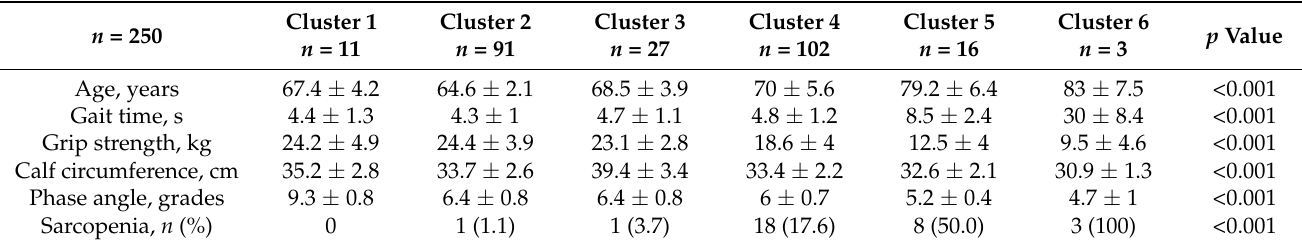
Figure 2. Variable maps, cluster map and characteristics of the six clusters. Left : Variable maps are colored according to a chromatic scale. The best physical performance and body composition values are colored in green (lower Age and higher Gait time, Grip strength, calf circumference, and phase angle), worst values are colored in red (higher Age and lower Gait time, Grip strength, Calf circumference, and Phase angle) and intermediate values are colored in yellow and orange. Right : Cluster Map obtained by the Neural Network Analysis. Colors were added randomly. Each identified cluster is labeled with a number as the test results worsen. Table 2. Characteristics of the six clusters.